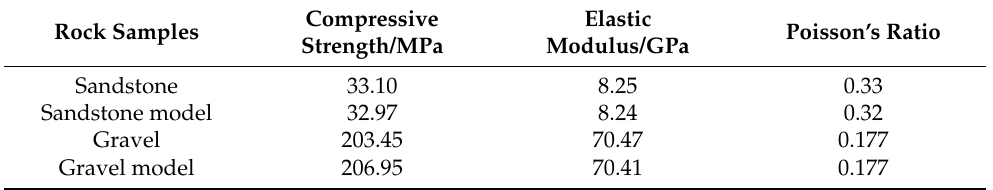
Table 1. Comparison of mechanical parameters between the rock samples and the DEM rock model.